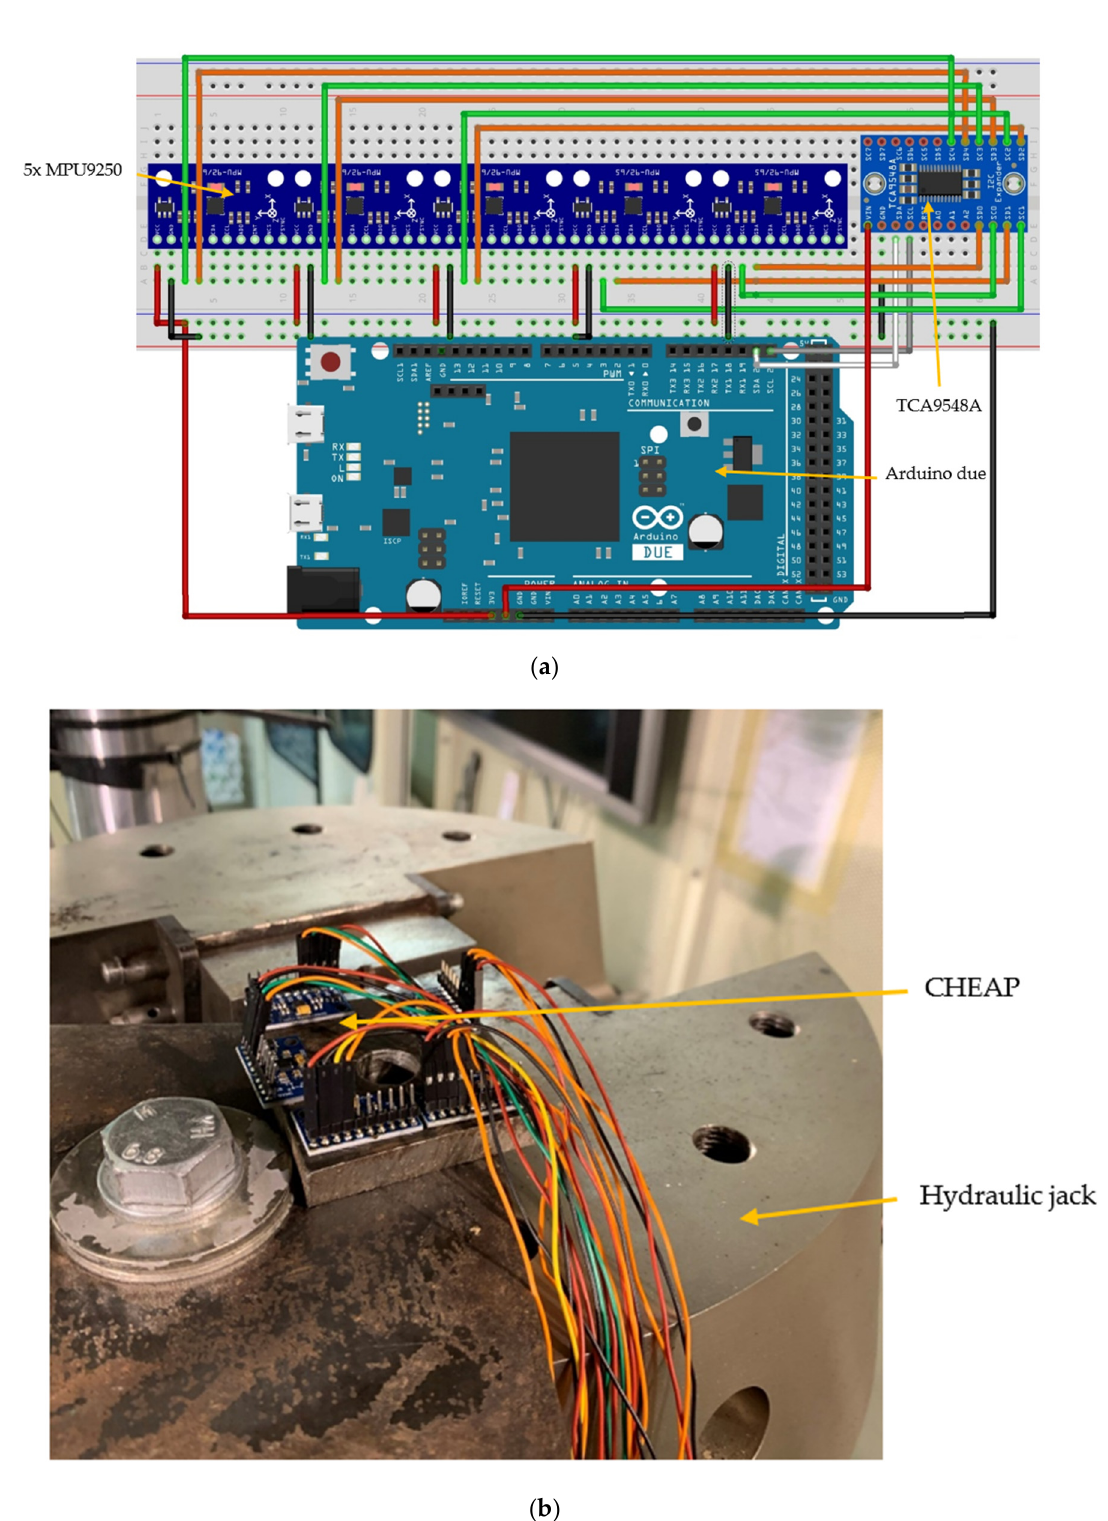
Figure 2. Developed signal and acquisition systems: ( a ) Schematic CHEAP and ( b ) CHEAP on the experiment jack. Once recorded by Arduino, the data was saved into a PC using Python. This